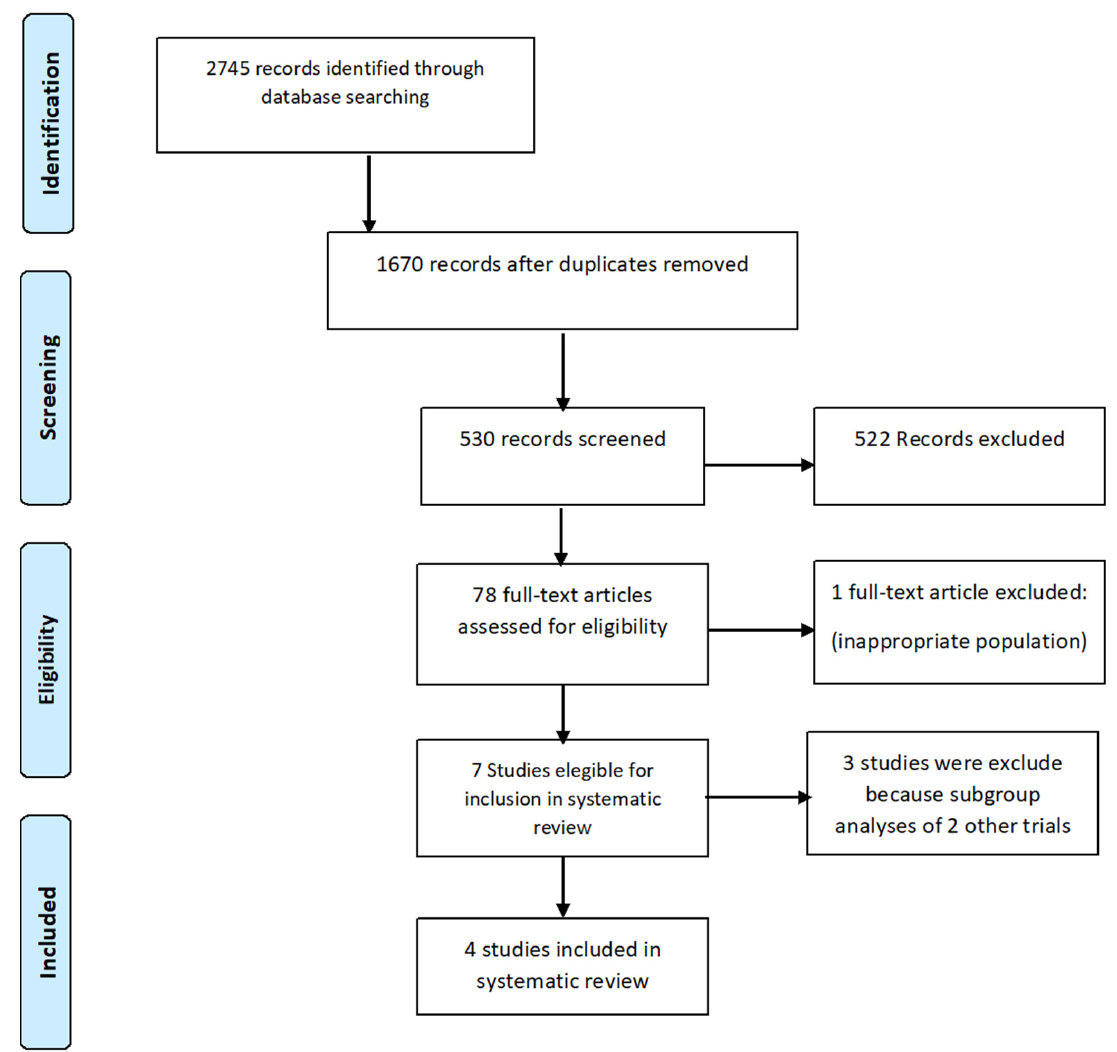
Figure 1. Preferred Reporting Items for Systematic Reviews and Meta-Analyses (PRISMA-P) flow diagram: search and selection process.